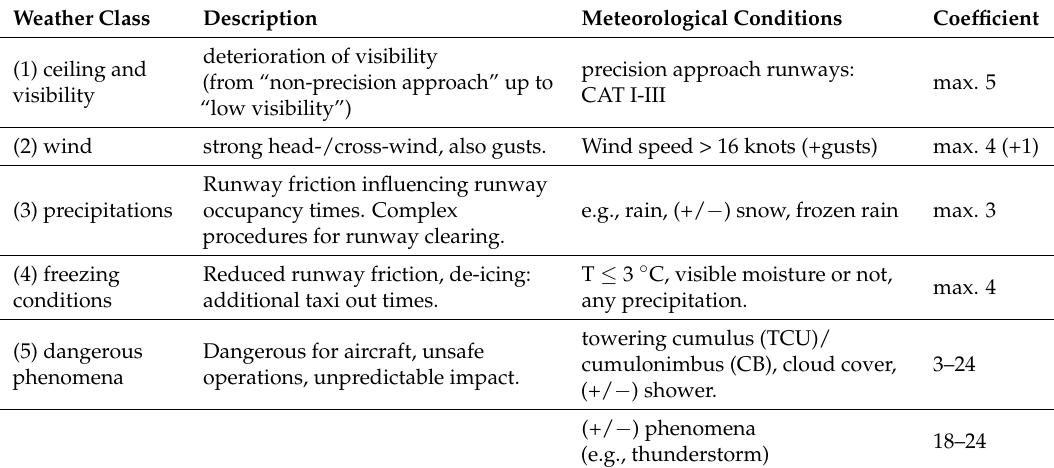
Table 3. Weather classes defined in the ATM Airport Performance (ATMAP)